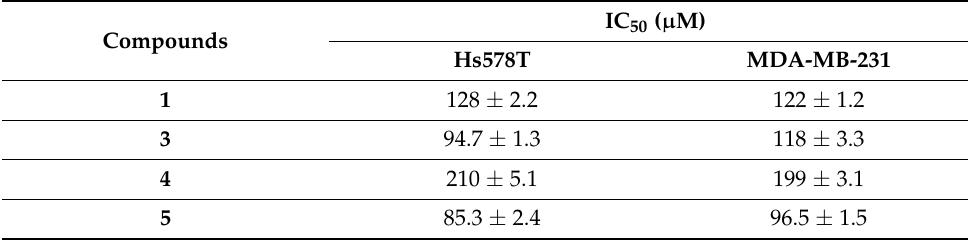
Table 5. Cytotoxic activity of the tested compounds at a half maximal inhibitory concentration (IC 50 ) in the TNBC cell lines Hs578T and